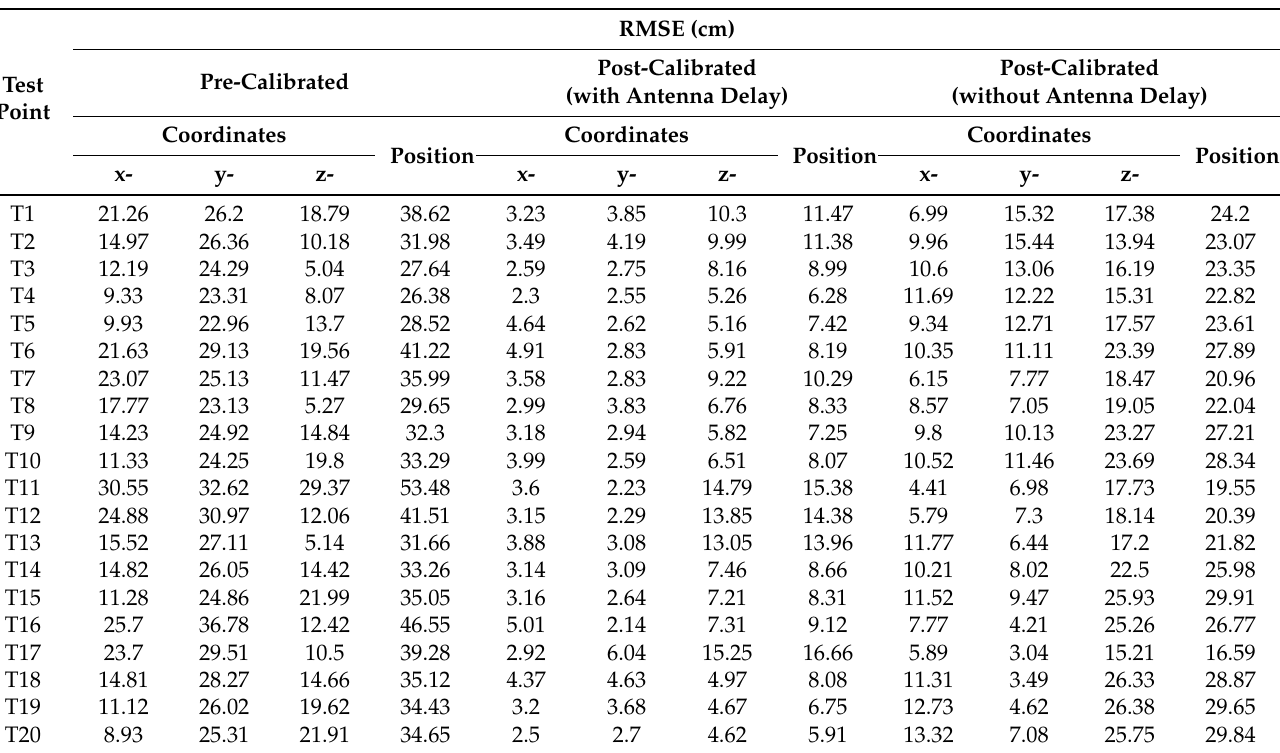
Figure 3. Mean of the estimated positions of the mobile node at each test point from MSR for the three calibration cases of anchor nodes: ( a ) pre-calibrated case, ( b ) post-calibrated (with antenna delay) case, and ( c ) post-calibrated (without antenna delay) case. Table 2. Comparison of RMSEs (unit: cm) of the estimated xyz-coordinates and positions of the mobile node at each test point from MSR for the pre-calibrated, post-calibrated (with antenna delay), and post-calibrated (without antenna delay) cases of anchor